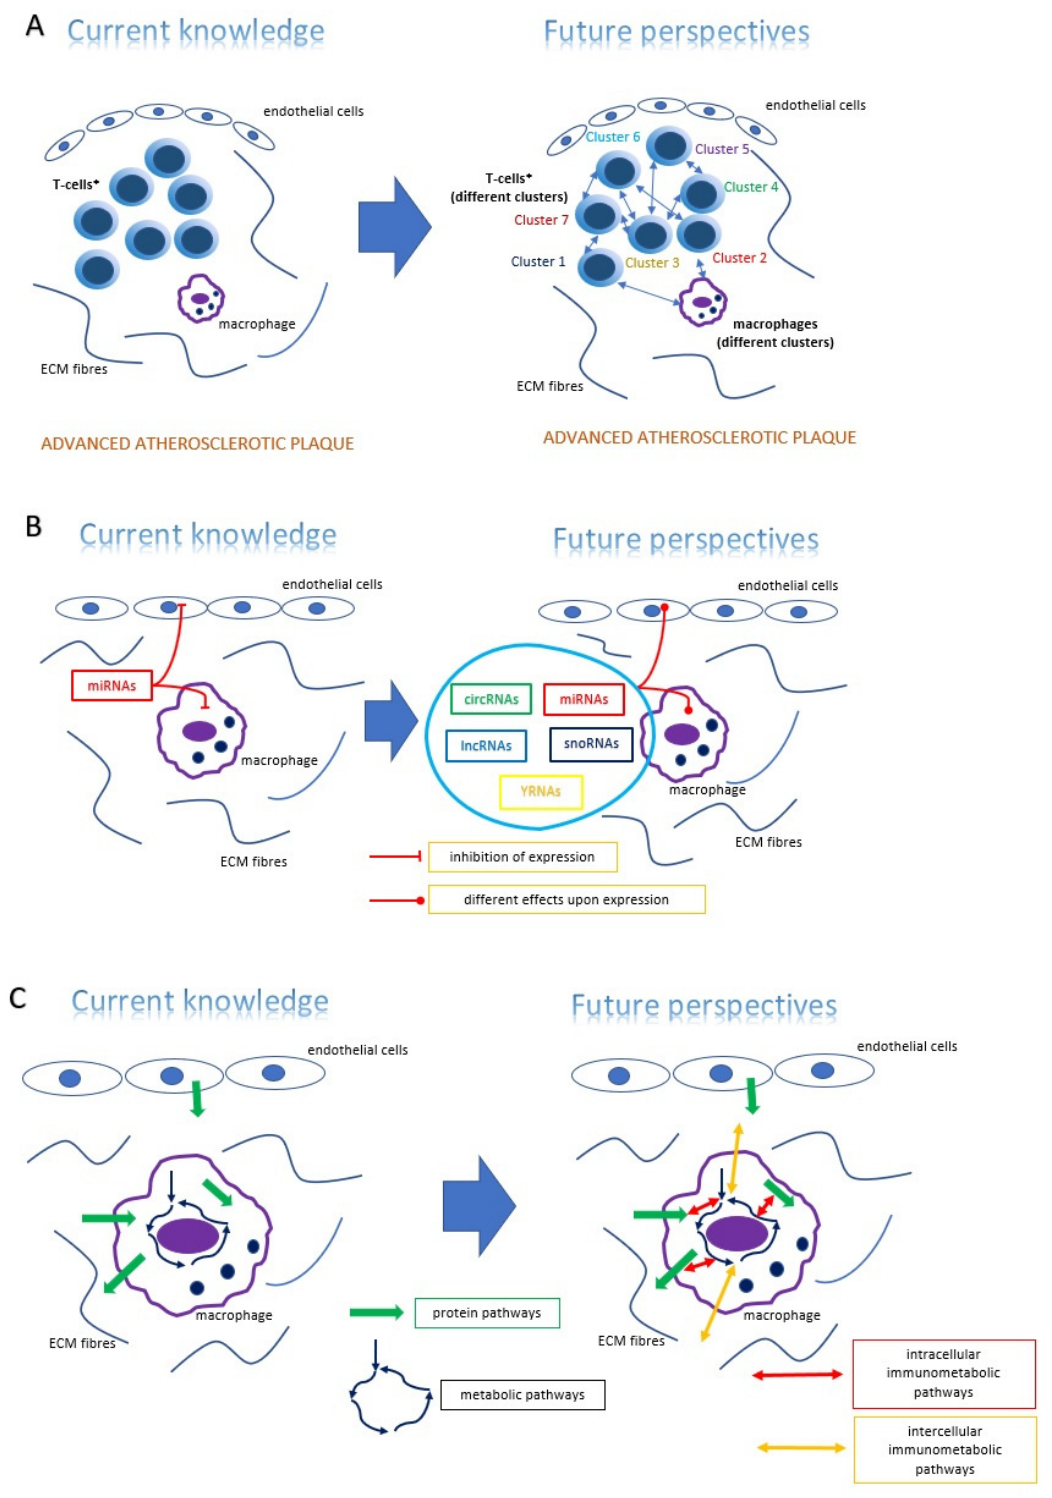
Figure 3. Insight into the perspectives of future research on atherosclerotic plaque—three main proposed directions of exploration: A—heterogeneity of immune cells, B—non-coding RNA influence, C—immunometabolism.